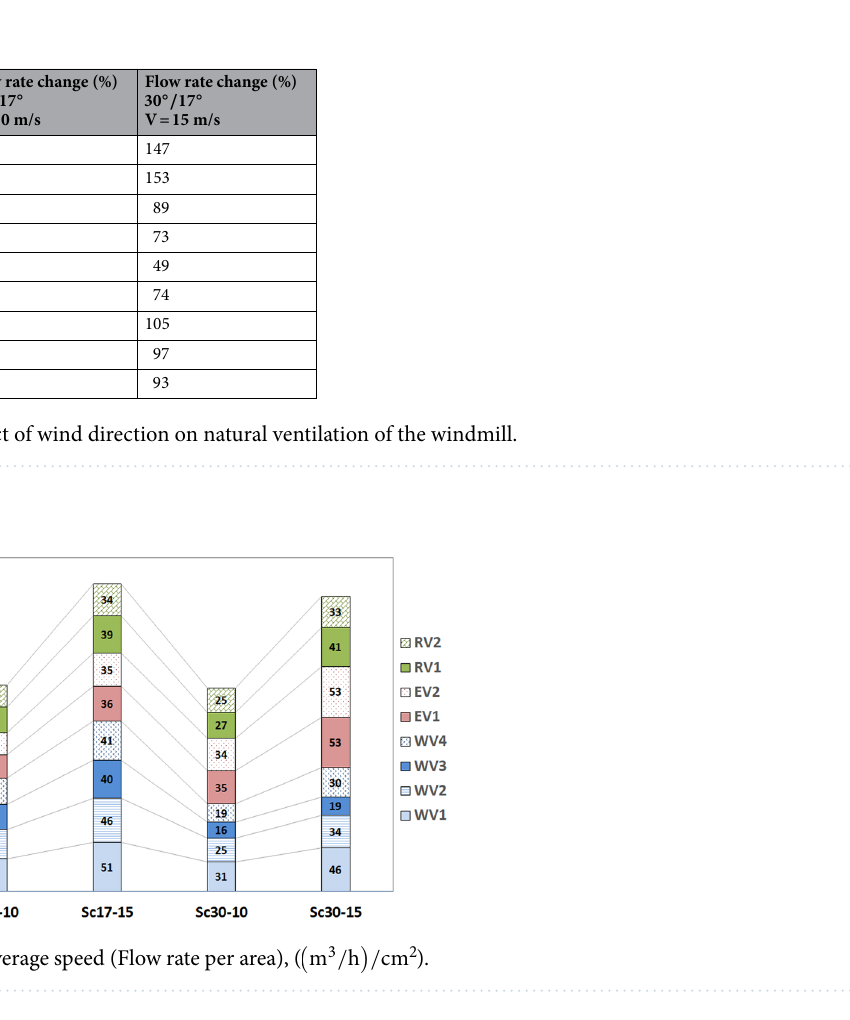
Table 3. Effect of wind speed on natural ventilation of the windmill.